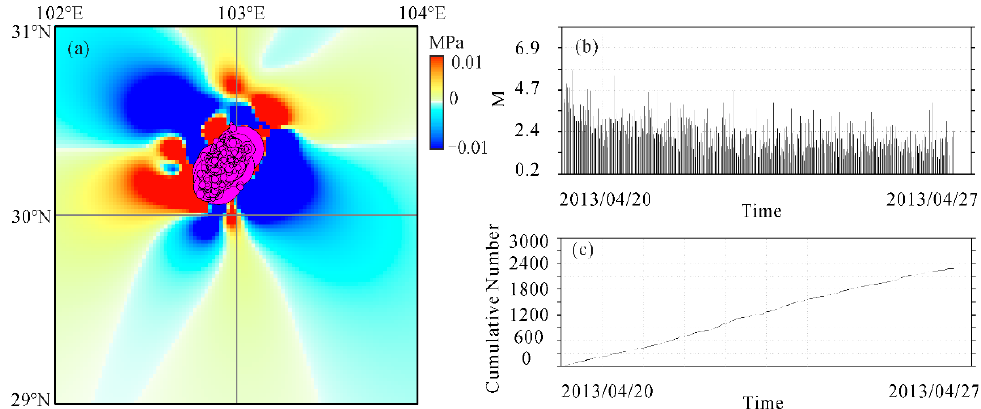
Figure 5. ( a ) Distribution of coseismic Coulomb failure stress changes caused by the 2013 Ms 7.0 Lushan earthquake at the depth of the mainshock and aftershocks (Xu et al. [5]). ( b ) Temporal distribution of aftershock magnitudes. ( c ) Cumulative number of aftershocks over time.